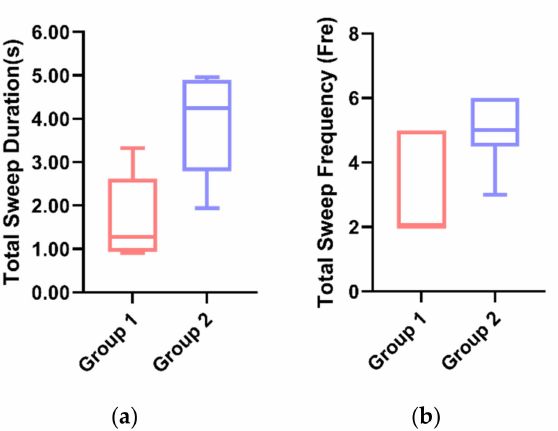
Figure 6. ( a ) Individual differences in the total sweep duration between the two groups. ( b ) Individ- ual differences in the total sweep frequency between two